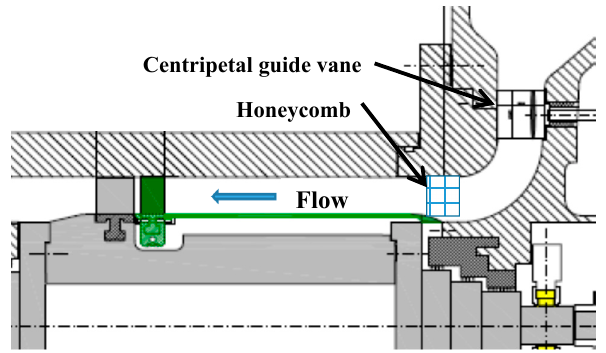
Figure 1. Meridional sketch of the axial turbine section.